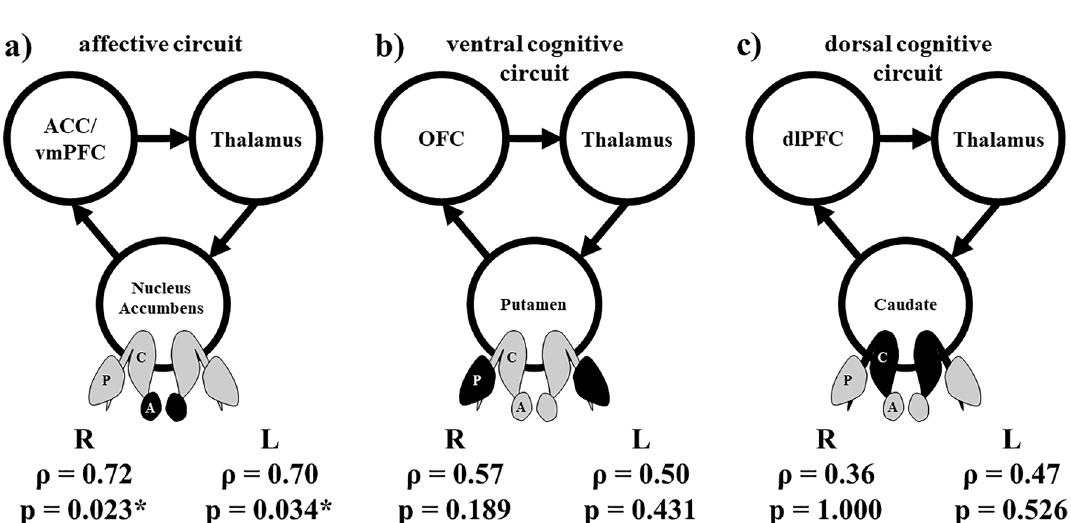
Figure 2. The correlation (ρ) between the “Checking” scores and the volumes of the striatal components of the three major OCD loops 12 . ( a ) Nucleus accumbens, ( b ) putamen, and ( c ) caudate. A p value < 0.05 is statistically significant. ACC, anterior cingulate cortex; dlPFC, dorsolateral prefrontal cortex; L, left; OFC, orbitofrontal cortex; R, right; vmPFC, ventromedial prefrontal